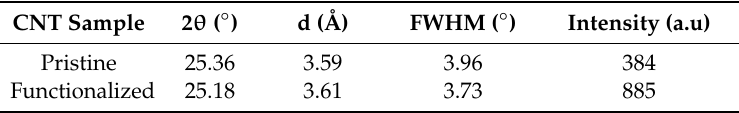
Figure 6. X-ray di ff raction (XRD) pattern of ( a ) pristine CNTs, ( b ) functionalized CNTs and ( c ) Figure 6. X-ray diffraction (XRD) pattern of (a) pristine CNTs, (b) functionalized CNTs and (c) ZrO 2 -fCNTs. ZrO 2 -fCNTs. Table 3. XRD parameters of CNT samples of the (002) plane. Table 3. XRD parameters of CNT samples of the (002) plane.